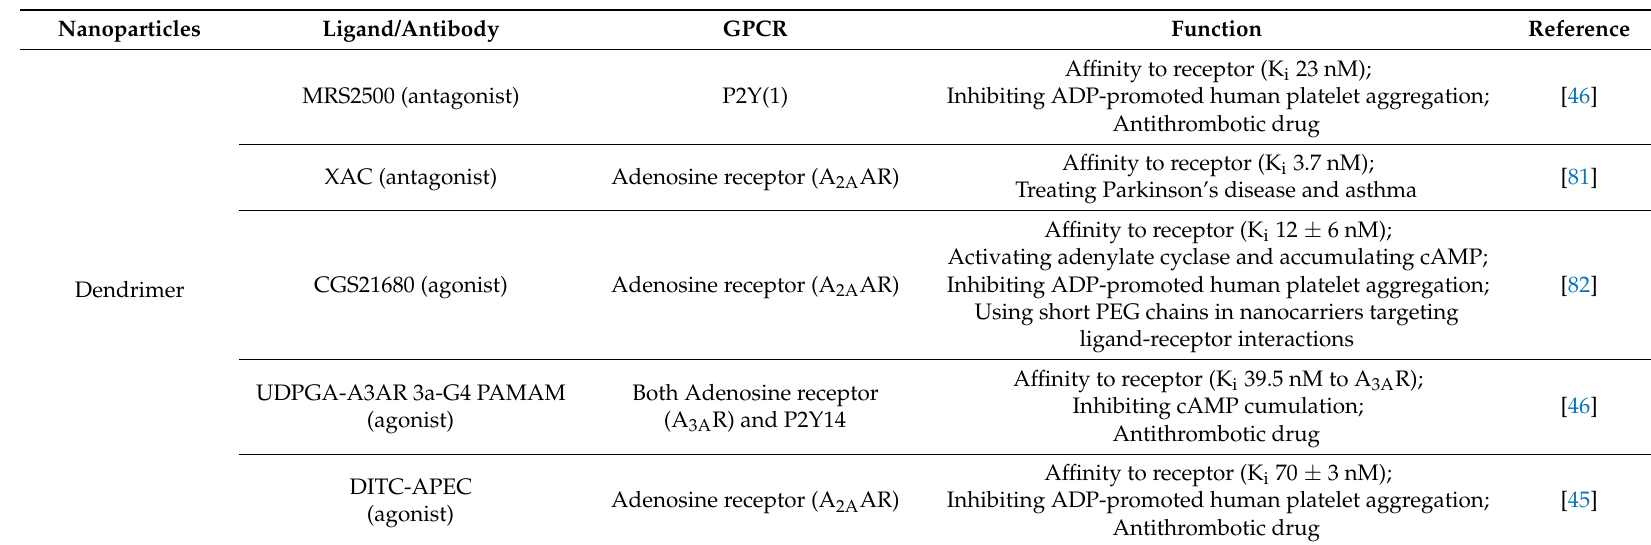
Table 1. Recent applications of NPs targeting